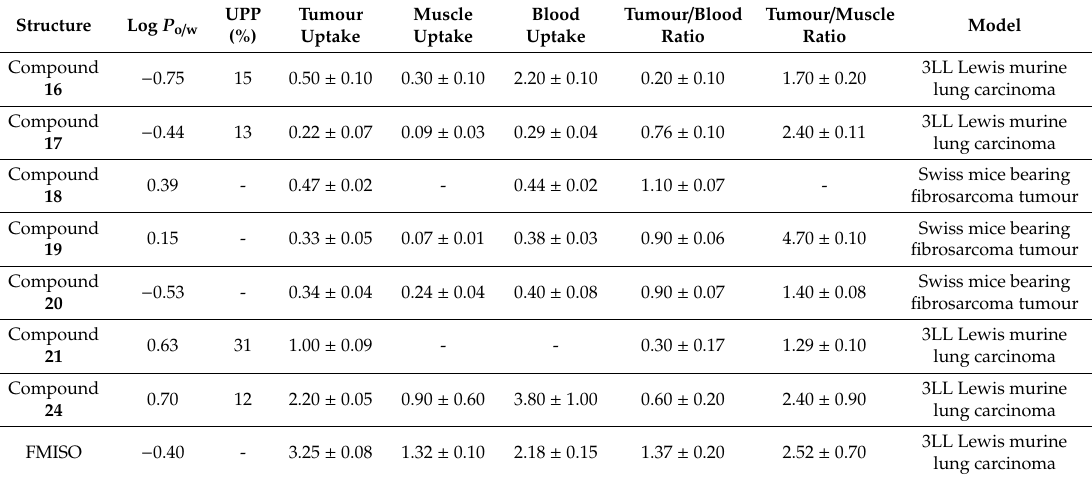
Table 4. Comparison of “in vitro” and “in vivo” uptake of a series of 5-nitroimidazolic [ 99m Tc]Tc complexes labelled using di ff erent strategies. (Biodistribution values are expressed in %D / g ± SD ( n = 3) at 1